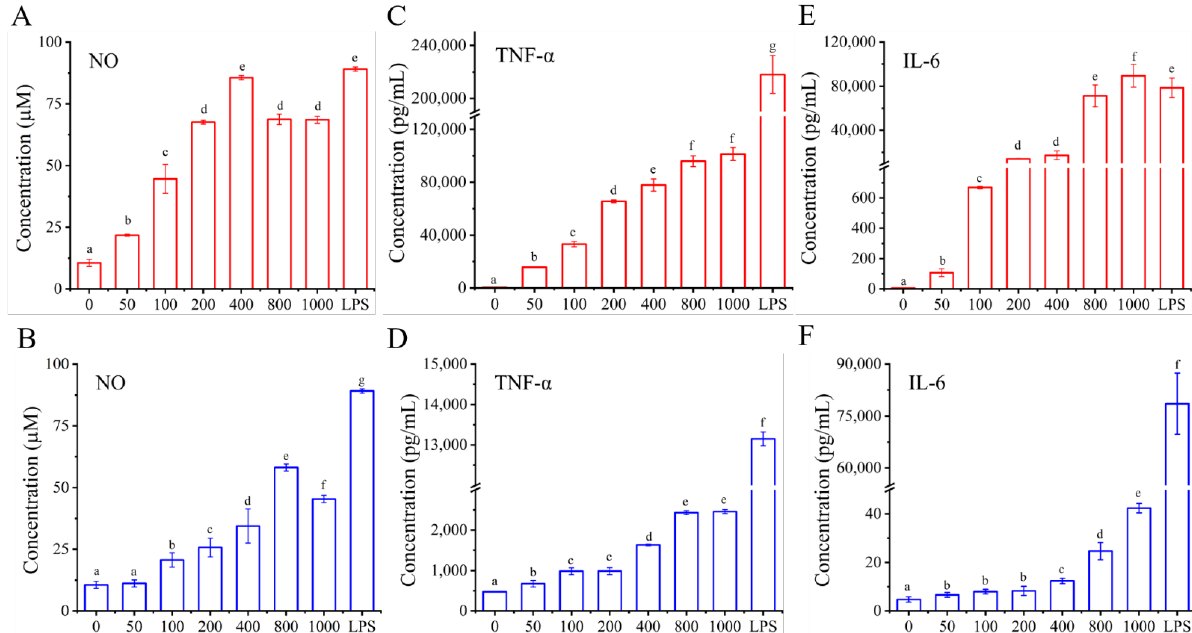
Figure 7. The effect of I01-2 and I01-4 on the production of NO ( A , B ), TNF- α ( C , D ), and IL-6 ( E , F ) in RAW 264.7 cells, respectively. The group incubated with medium only (0 µ g/mL of I01-2 and I01-4) was used as a control. Different superscript letters (a–g) indicate significant differences ( p < 0.05) between the groups.